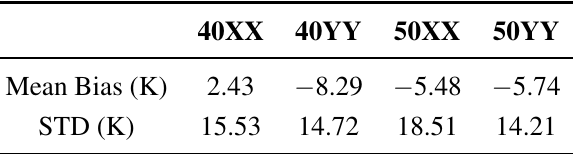
Table 1. Mean bias and bias standard deviation (STD) between SMOS T estimations for the period 1 to 15 July